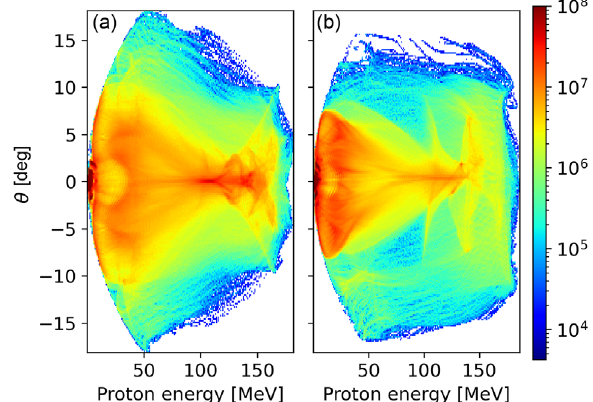
FIG. 4. Angular distribution for different energies of the dual- pulse setup with a 0 ¼ 100 (a) and the compared single pulse (b). The color map (clipped at 10 8 ) corresponds to the number of particles in that specific angle/energy bin. The angle is defined as θ ¼ arctan ð p =p y x Þ .